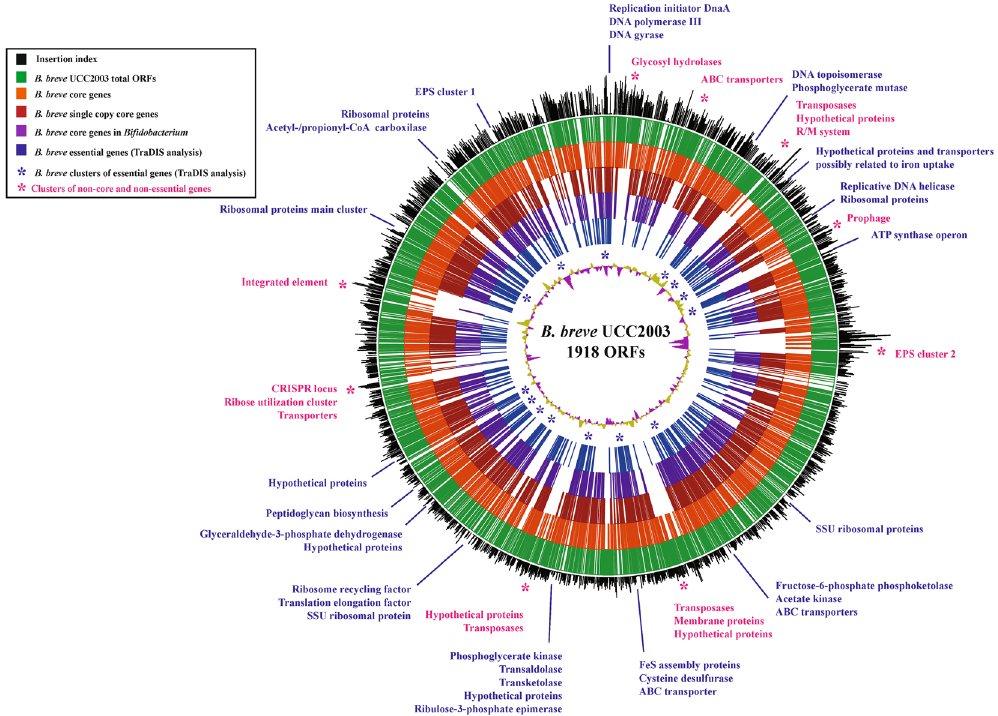
Figure 1. Genome-wide distribution of transposon insertions in B. breve UCC2003. Circular plot showing gene content, insertion distribution and gene comparison to Bifidobacterium and B. breve core genomes. Circular tracks are numbered from 1 (outer track) to 7 (inner track). Track 1 represents transposon insertion densities; track 2 indicates forward and reverse genes predicted in B. breve UCC2003 genome; track 3 indicates core B. breve genes; track 4 indicates B. breve core genes present in single copy; track 5 represents B. breve single copy core genes present in Bifidobacterium genus core genes; track 6 represents TraDIS predicted essential genes and track 7 represents GC bias, khaki indicates values > 1; purple <